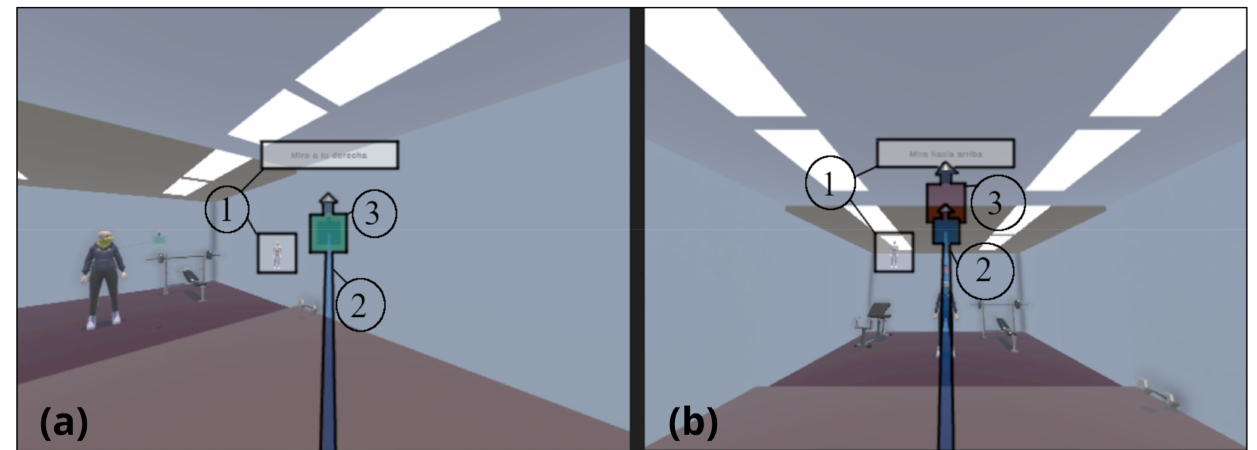
Figure 2. Examples of looking right ( a ) and looking up ( b ). Elements highlighted with number 1 are the instructions consisting of puppet animation and text output. Elements highlighted with number 2 are the visual feedback about user’s gaze. Finally, elements highlighted with number 3 are the targets to